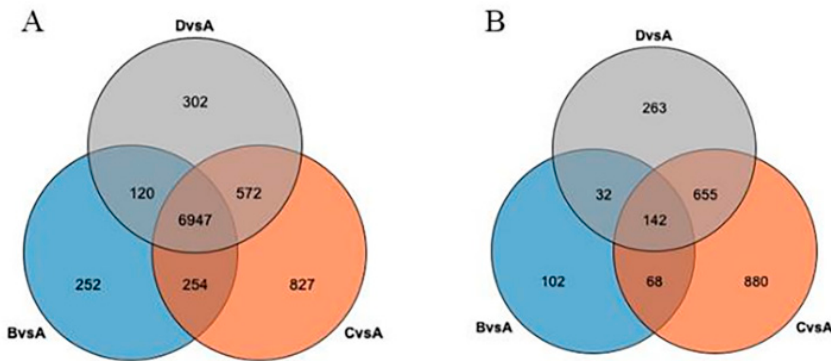
Figure 3. The number of common and unique alternative splicing genes in wild jujube CK and each treatment comparison group. ( A ) Total number of alternative splicing genes; ( B ) Number of common alternative splicing difference genes.